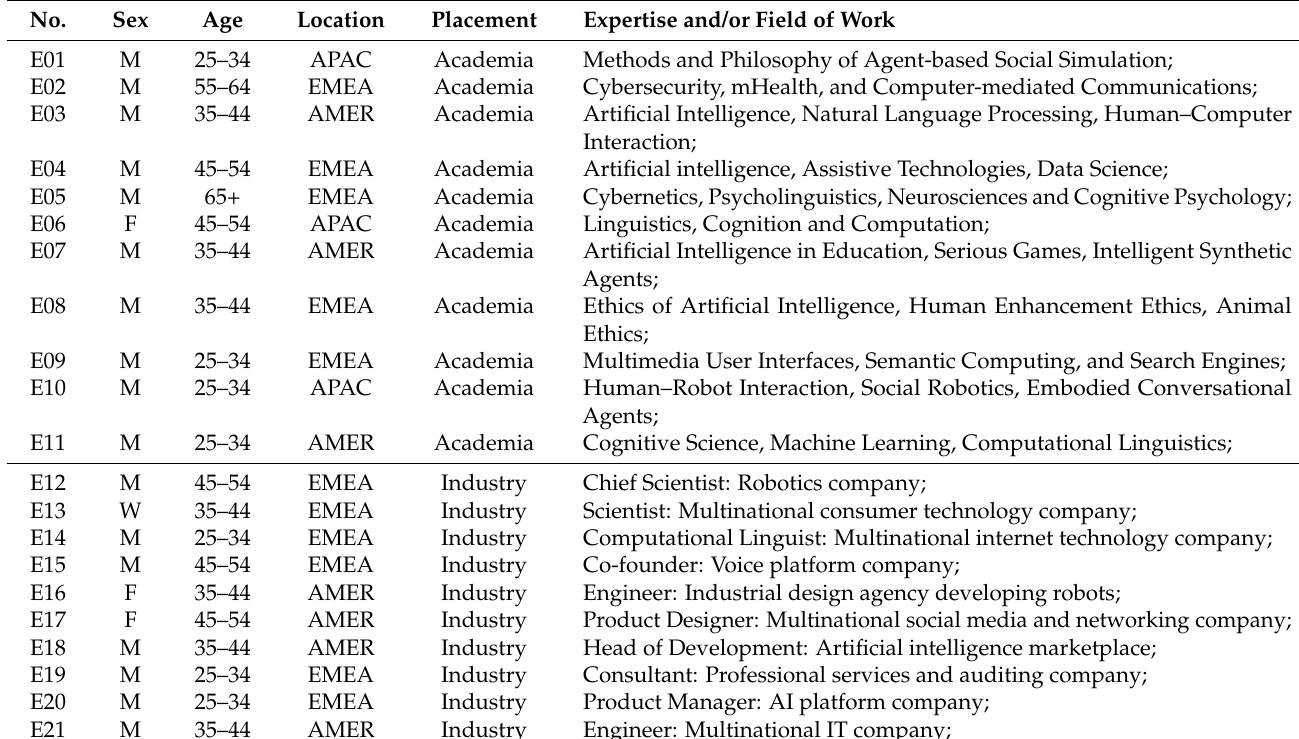
Table 2. Experts who participated in the Delphi